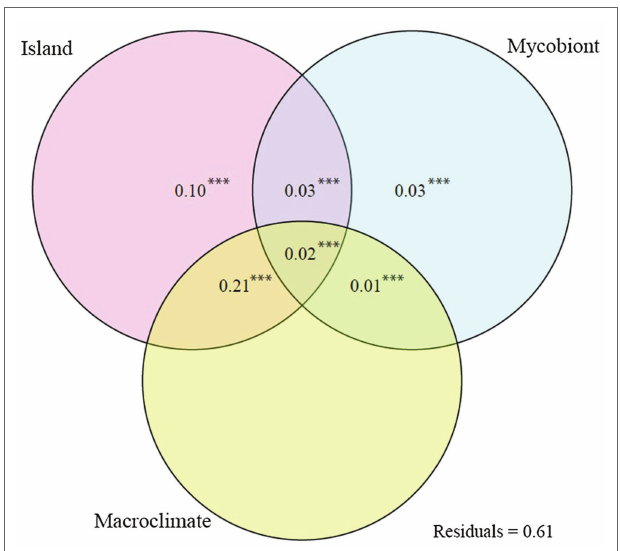
FIGURE 3 | Venn diagram showing variance partitioning between the simple and combined effects of the explanatory variables of the dbRDA (island, mycobiont identity, and macroclimate) and their mixed effects. The explained variation indicated are the adjusted R 2 values. Values <0 not shown. *** p <